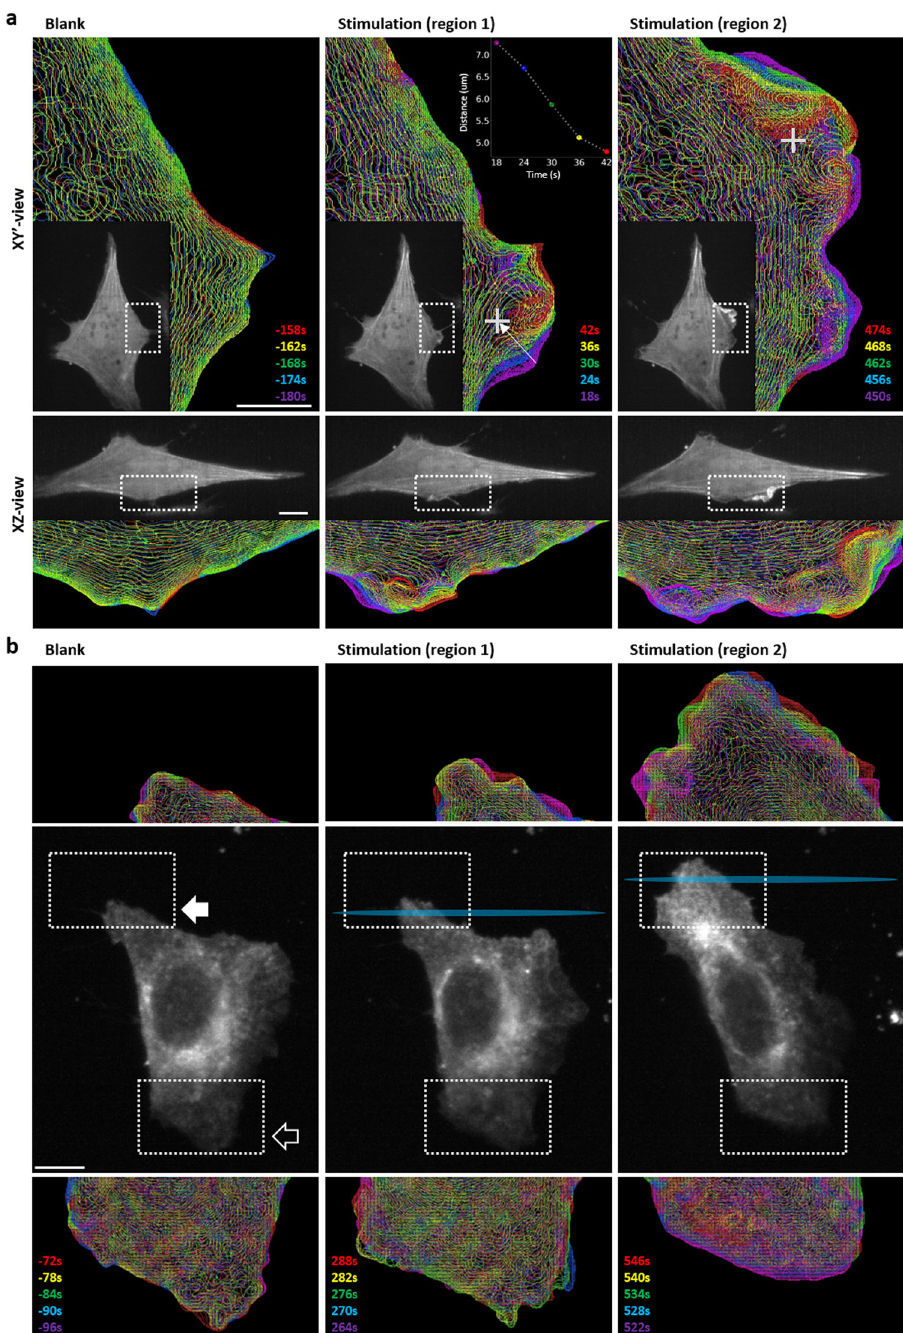
Fig. 4 The dynamics of the cellular membranes upon sub-cellular activation. a The cells expressing F-tractin-mCherry-p2a-CRY2mCFPiSH-p2a- CIBNEYFP-CAAX are illuminated by a single Bessel beam activation. The cross represents the activation site. To demonstrate the dynamic behavior of fi lamentous actin, intensity contours were plotted before and after the stimulation. At region 1, the distance of the membrane edge along the white arrow is shown in the inset. Different color represents different time points after stimulation. The top images are XY orthographic view, and the bottom images are XZ view with 32.8° rotation on X-axis. The gray images are the original images. b The Bessel fan was used to stimulate the endothelial growth factor receptor (EGFR)-CRY2olig-mApplex3-expressing cells at the trailing edge. The images in the center row are the whole-cell images at different times post- stimulation. The stimulation areas are marked as cyan. The solid arrow indicates the original trailing edge, and the hollow arrow indicates the original leading edge. Images on the top and bottom rows are enlarged views of the dashed box area in the middle row. Different colors represent different time points. Scale bar 10 μ